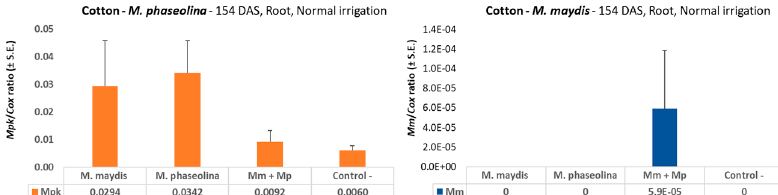
Figure 8. qPCR diagnosis of M. maydis and M. phaseolina in cotton at the end of the season (154 DAS). The experiment was conducted in 2018. The control is a soil taken from a nearby field with minor levels of M. maydis or M. phaseolina infestation. M. maydis relative DNA ( Mm ) or M. phaseolina relative DNA ( Mpk ) abundance was normalized to the cytochrome c oxidase (Cox) DNA. Vertical upper bars represent the standard error of the mean of 10 replications (pots, each containing one plant).